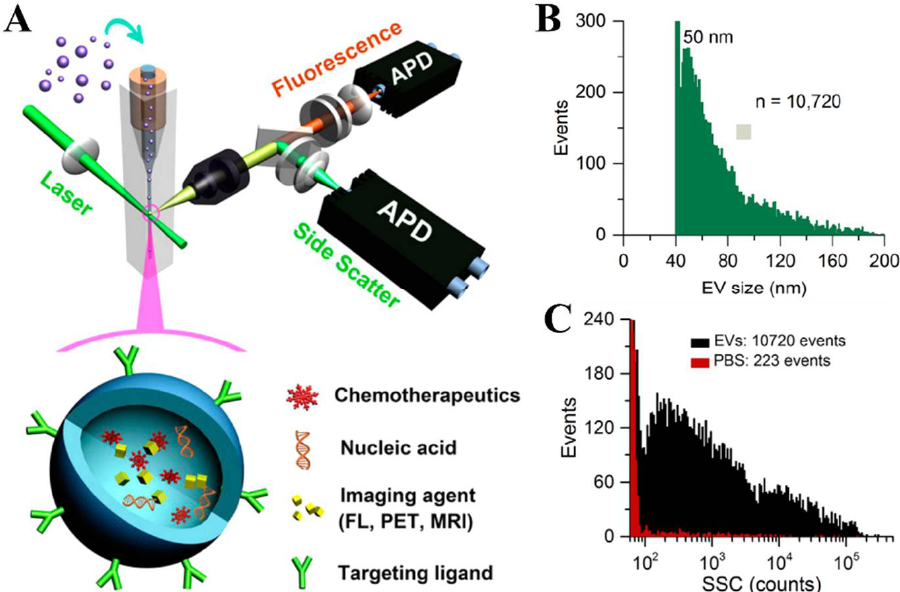
Figure 3. A high-resolution flow cytometry for the individual EV analysis. ( A ) Schematic diagram of a laboratory-built HSFCM system by Yan’s group. Reprinted with permission from [56]. Copyright 2014, American Chemical Society. ( B ) Histogram of the particle size for the EV sample by HSFCM ( n = 10,720). Reprinted with permission from [57]. Copyright 2018, American Chemical Society. ( C ) Detection of the side scattering (SSC) of PBS (red) and EVs (black), collected by HSFCM over 2 min each. Reprinted with permission from [57]. Copyright 2018, American Chemical Society.